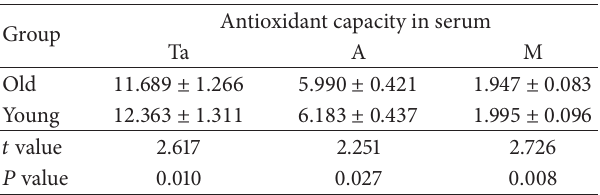
Table 2: Total antioxidant capacity (Ta), average activity (A), and mass of antioxidant substances (M) in serum of two different groups (iodimetric